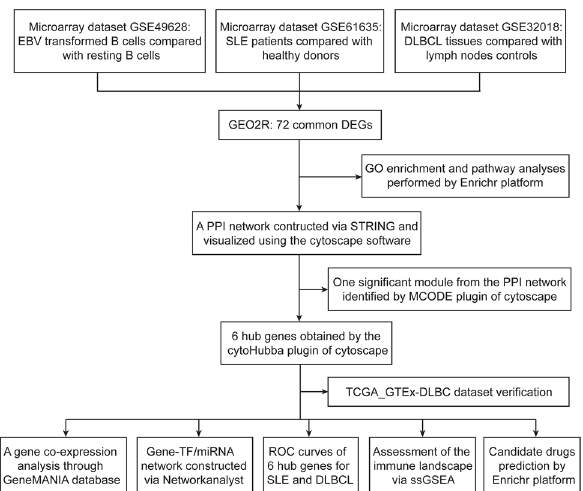
Figure 1. Flowchart for this